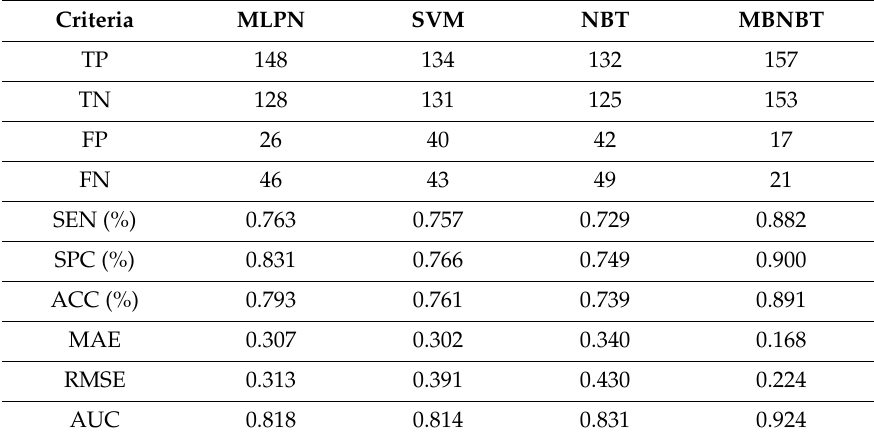
Table 1. Model performance using the training